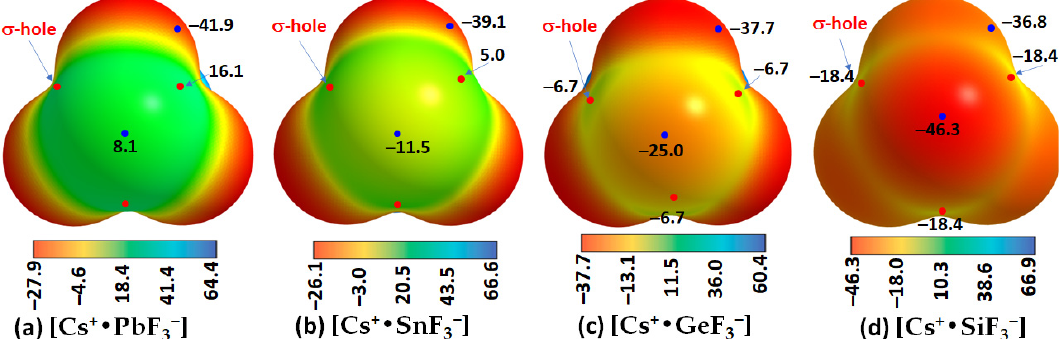
Figure 12. ( a – d ) The [ ω B97Xd/def2-TXVPPD] computed potential on the electrostatic surface of